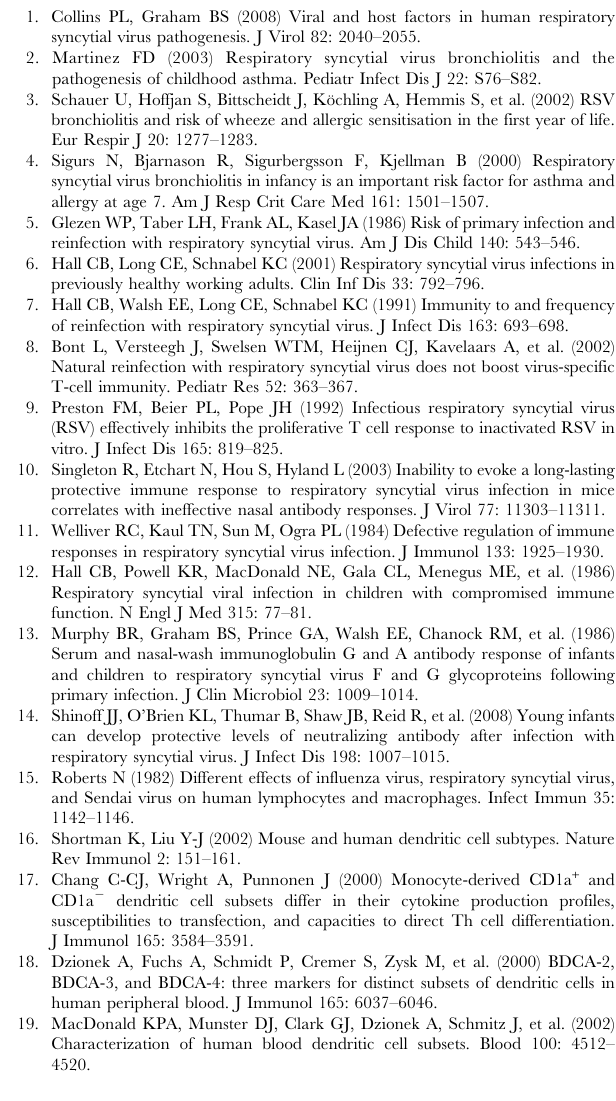
are denoted by bold blue values in gray shaded boxes while weak negative correlations are defined as r . 0 and 0.01 , p , 0.05